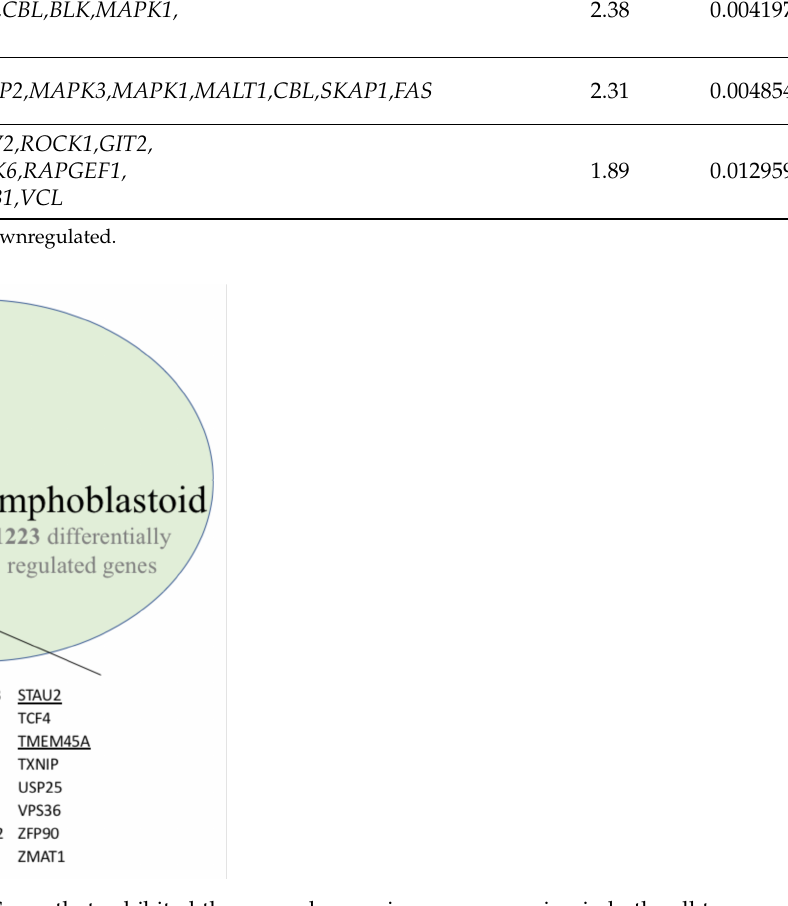
Figure 2. Differentially expressed genes detected in both skin fibroblast and lymphoblastoid cell lines. Genes that exhibited the same changes in gene expression in both cell types are